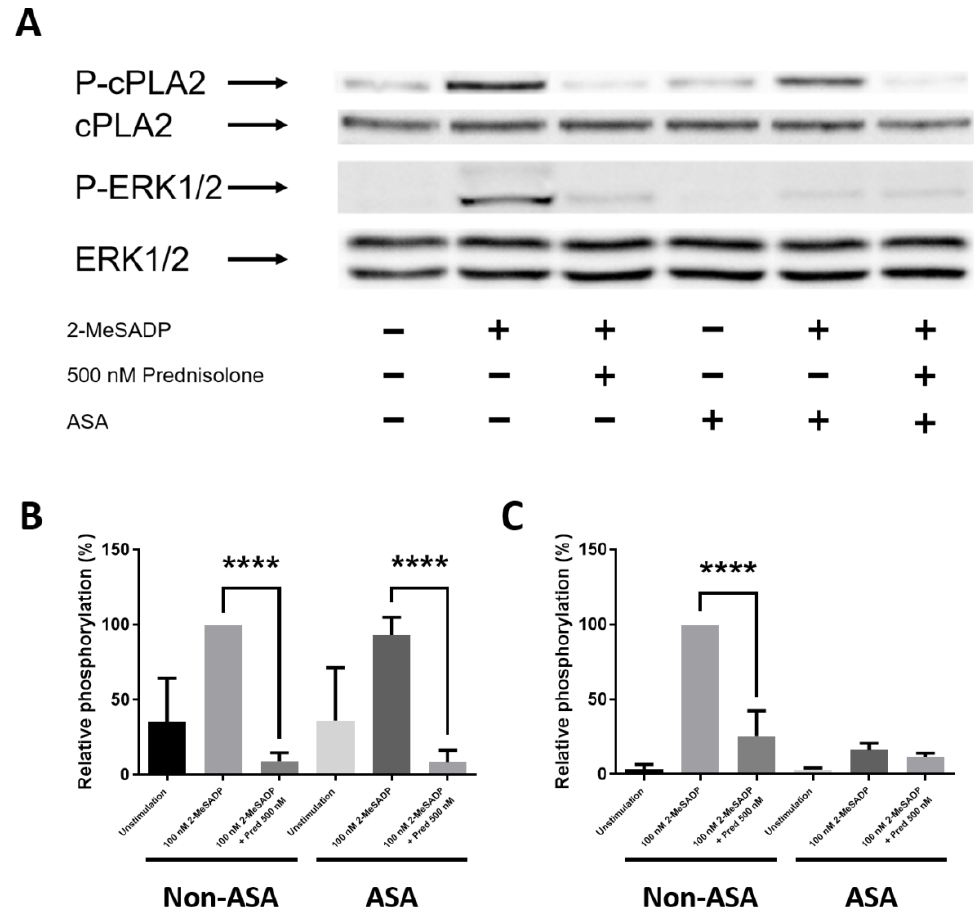
Figure 5. The effect of prednisolone on 2-MeSADP-induced cPLA 2 and ERK phosphorylation in platelets. ( A ) Non-aspirinated and aspirnated washed platelets were stimulated with 100 nM 2-MeSADP in the presence of 500 nM prednisolone. Proteins were immunoblotted using anti-phospho-cPLA 2 , anti-cPLA 2 , anti-phospho-ERK, and anti-ERK antibodies ( n = 9). Relative phosphorylation of ( B ) cPLA 2 and ( C ) ERK were expressed as a percentage compared to the 100 nM 2-MeSADP group in non-aspirinated platelets and are shown as mean ± SE. ****, p < 0.0001.